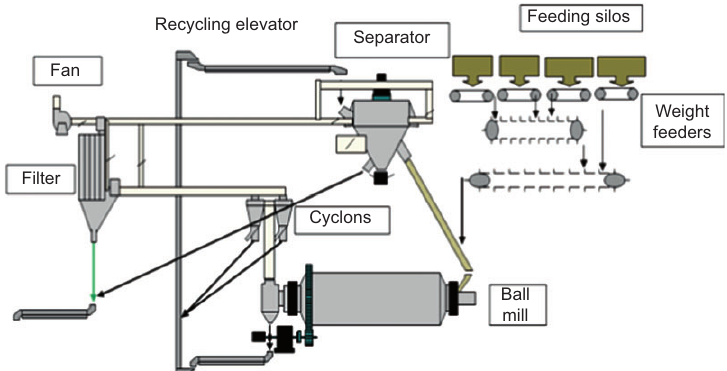
Figure 3 Closed circuit grinding